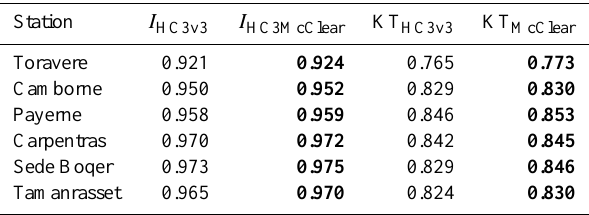
Table 2. Comparison of correlation coefficients for 15min irradia- tion and clearness index. Best values are in